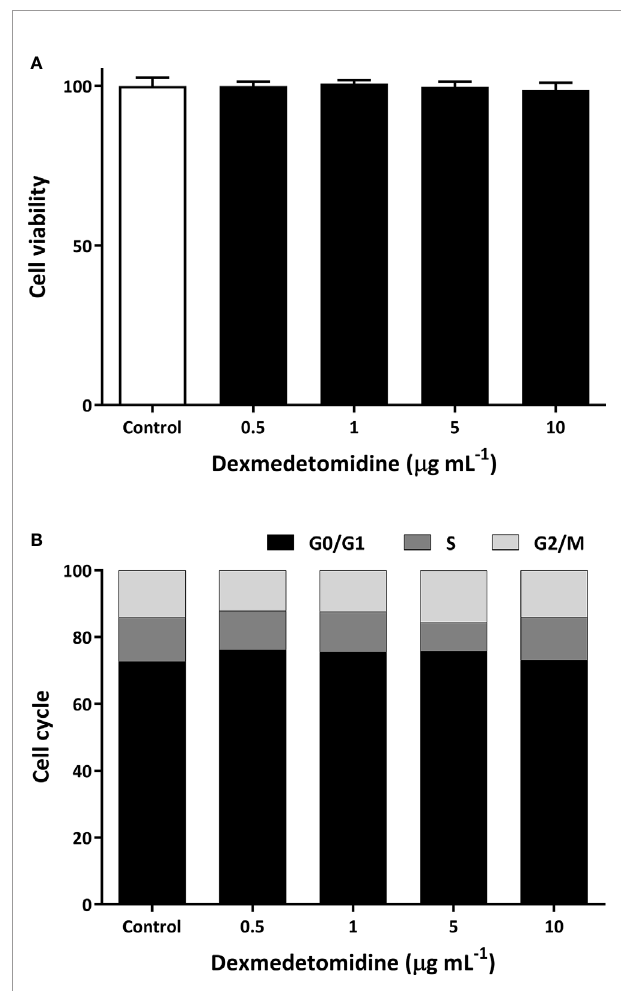
FIGURE 1 | Cell viability (A) and cell cycle (B) of SK-OV-3 human ovarian cancer cells with dexmedetomidine at 0.5, 1, 5, and 10 m g mL -1 . Error bars represent standard